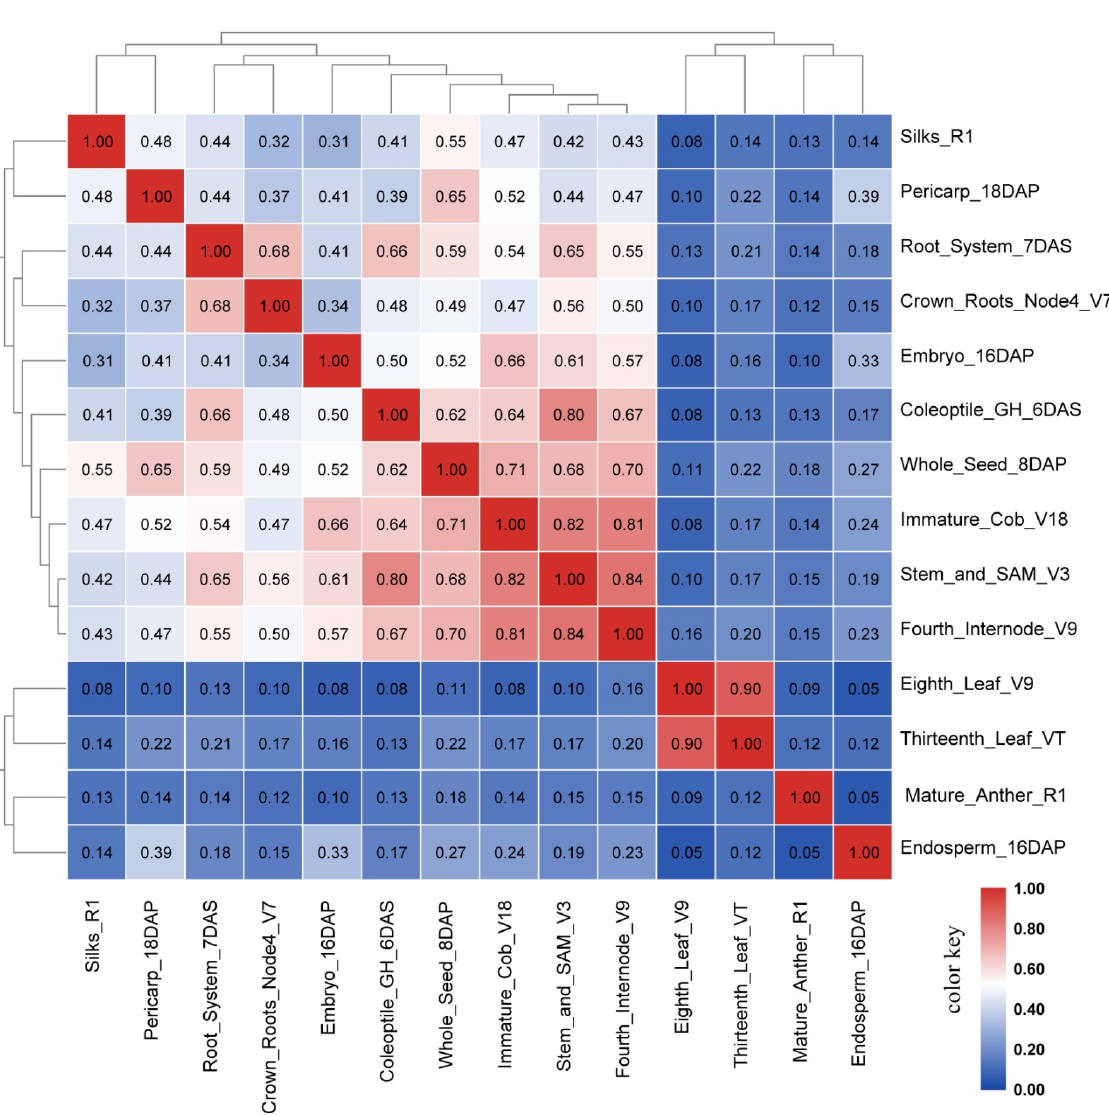
Figure 4. Pearson’s correlation coefficient r matrix of 14 selected tissues including mature anther. FPKM values for the transcripts of 39,456 genes in 14 selected tissues [70] were used to perform this correlation analysis. Pearson’s correlation matrix was drawn by software TBtools [74]. The numbers in this matrix are the Pearson’s correlation coefficients ( r ) between two tissues of 14 tissues selected.